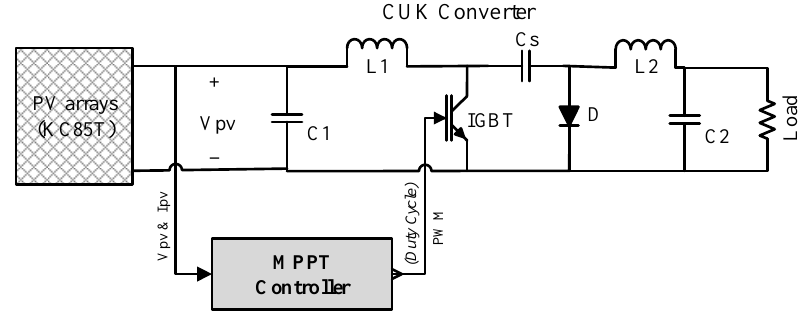
Figure 8. Topology of the proposed PV system.